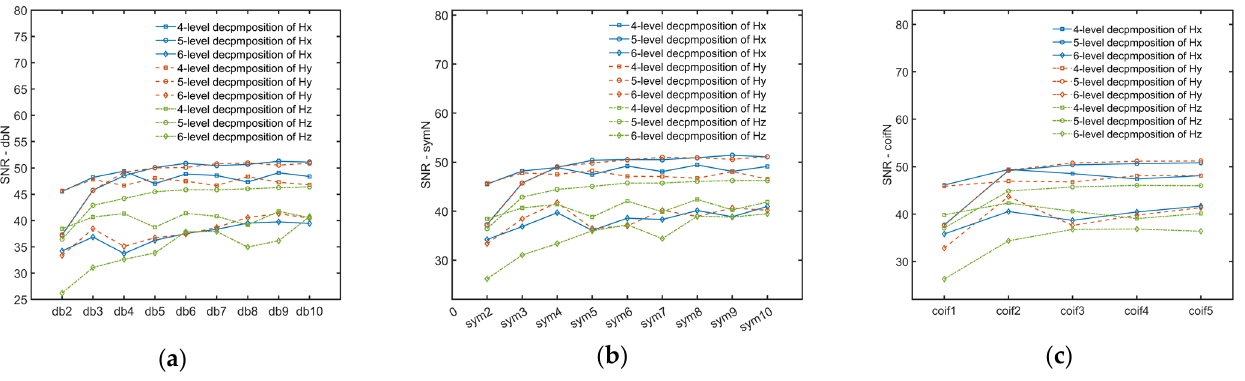
Figure 4. Denoising effect of different wavelet basis functions under different decomposition levels. ( a ) Denoising effect of dbN. ( b ) Denoising effect of symN. ( c ) Denoising effect of coifN.